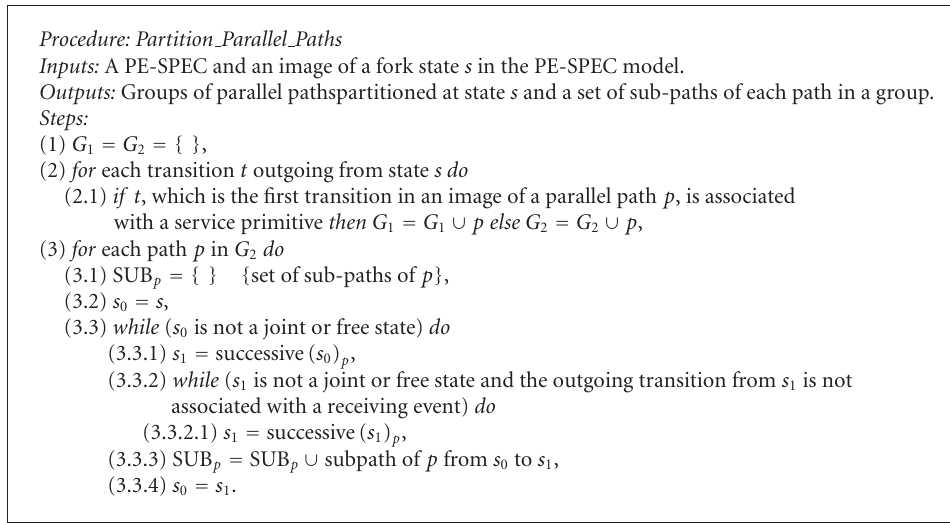
Algorithm 3: Partitioning